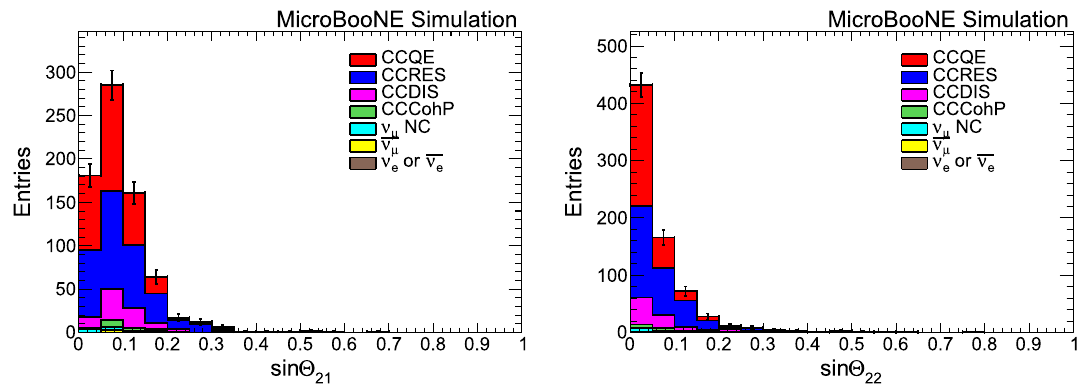
Fig. 32 Multiplicity = 2 Sin (cid:17) for candidate muon (left); for second track (right) from GENIE default MC. Black error bars represent MC statistical